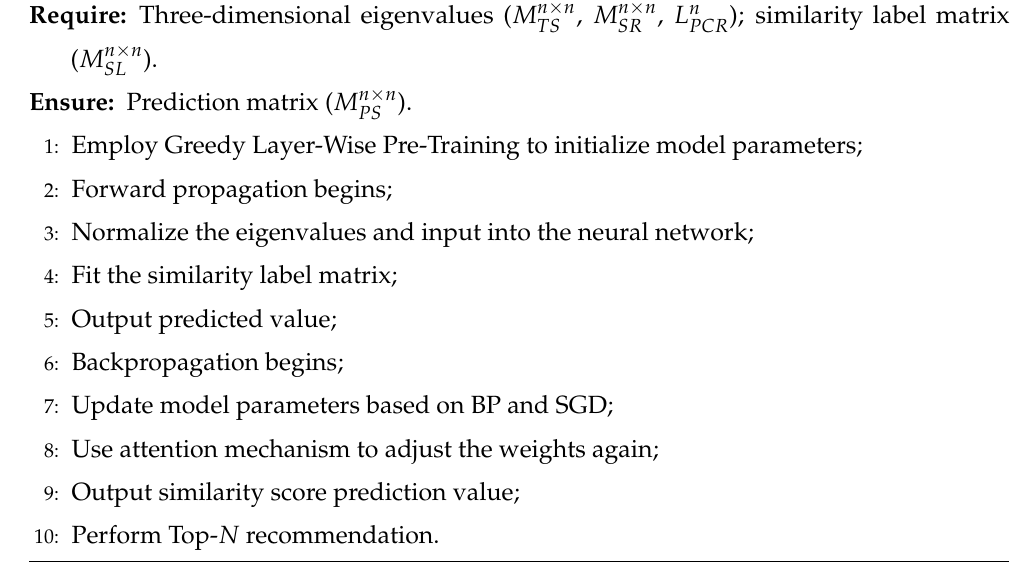
Algorithm 1 Personalized Scholar